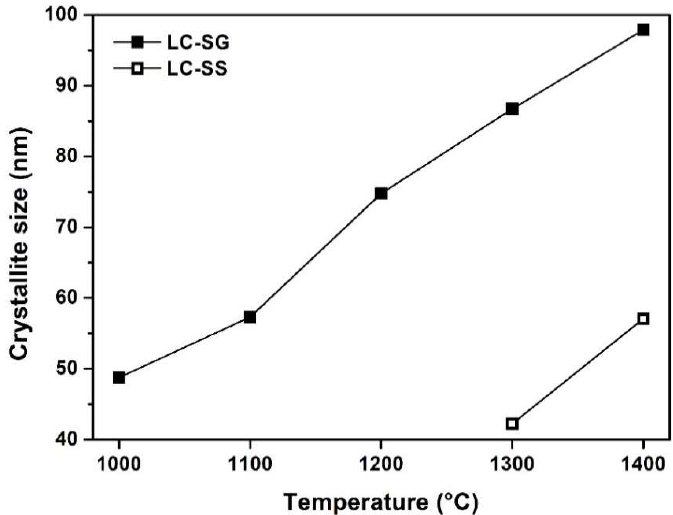
Figure 4. The average crystallite size of LC powders as a function of calcination temperature.